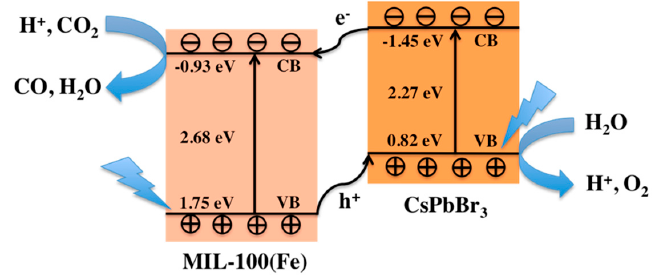
Figure 9. Schematics of the CO 2 photoreduction process on CsPbBr 3 / MIL-100(Fe) under visible light irradiation.